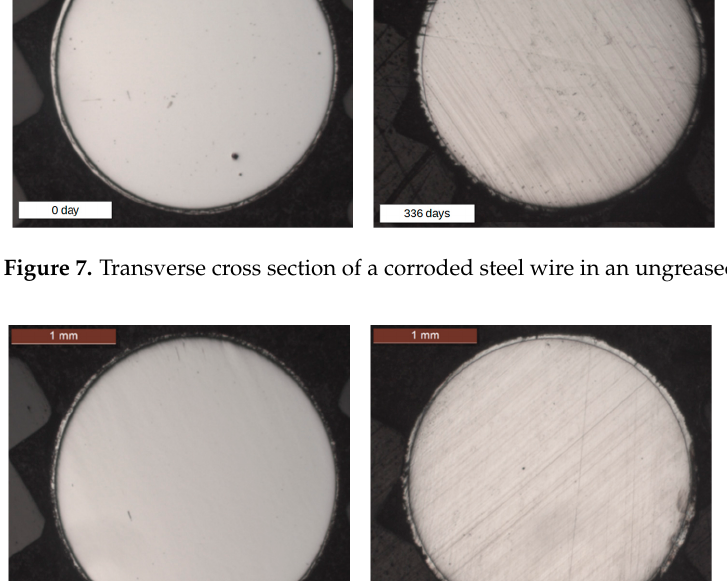
Figure 8. Transverse cross section of a corroded steel wire in a greased cable.